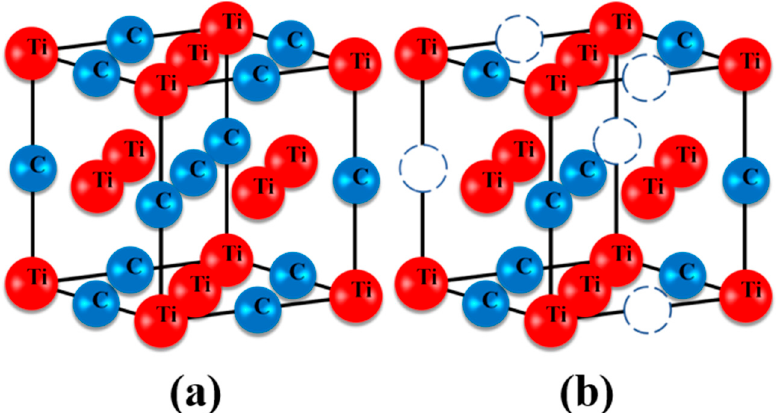
Figure 2. Crystal structure model of TiC: ( a ) Ideal crystal structure. ( b ) Defect crystal structure.